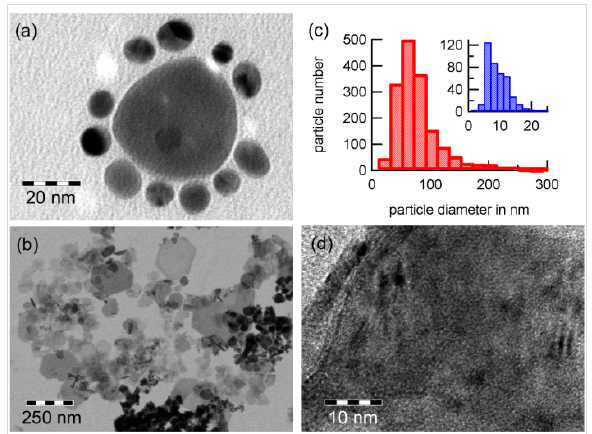
Figure 4: (a) Nanoparticles synthesized by micro emulsion approach and (b) by employment of the synthetic protein c25-mms6 after 15 days. The latter approach results in two different particle species of different sizes (c). Within a single particle, crystallites of different orien- tation can be found